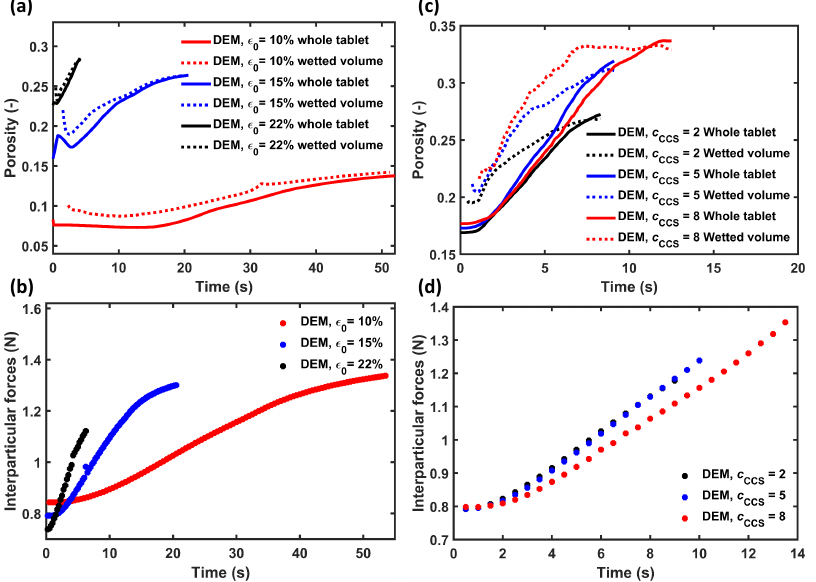
Figure 7. DEM simulation results. ( a ) PH101 tablets’ porosity for the whole tablet and for the wetted volume only. ( b ) Interparticle forces for PH101 tablets. ( c ) PH101/CCS tablets’ porosity analysed for the whole tablet and for the wetted volume only. ( d ) Interparticle forces for PH101/CCS